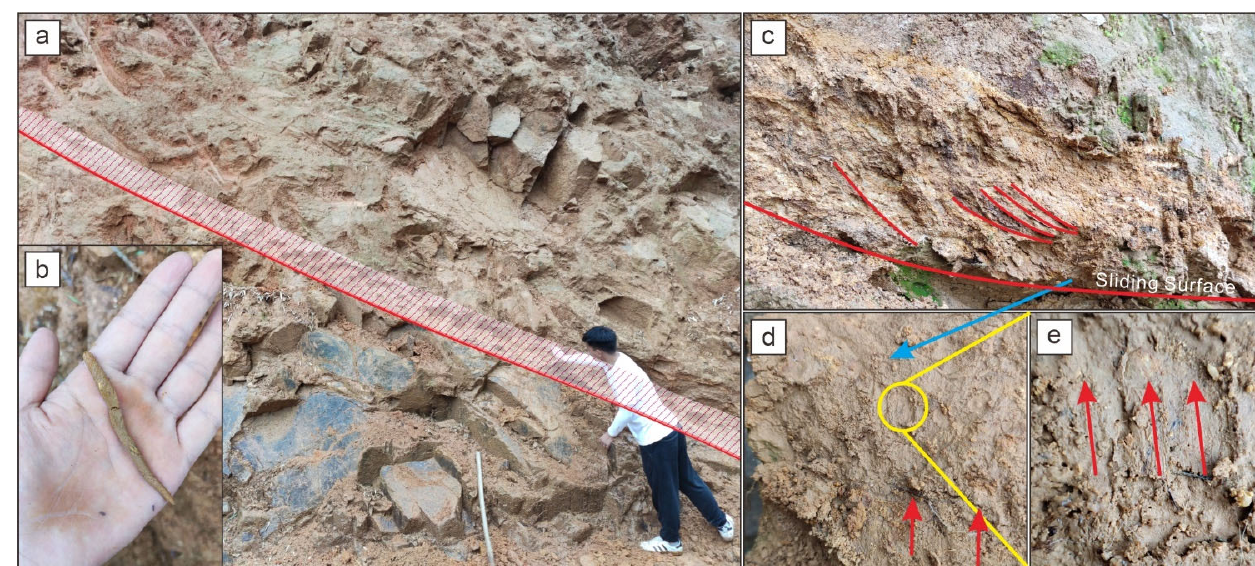
Figure 9. Slip soil photos at S1. ( a ) Sliding belt space distribution. ( b ) Slip soil rubbing test. ( c ) Arc-shaped arrangement of soil particles and a sliding surface. ( d ) Scratches on the sliding surface. ( e ) Enlarged view of scratches.